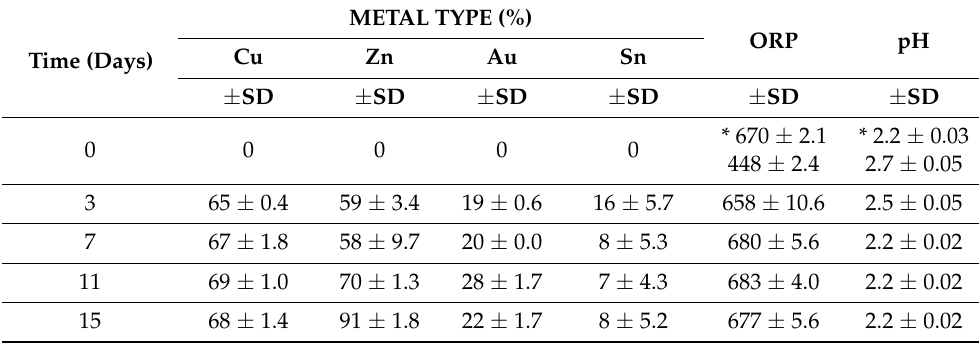
Table 2. Extraction efficiency of heavy metals from PCBs waste in stirred tank bioreactors and evaluation of ORP and